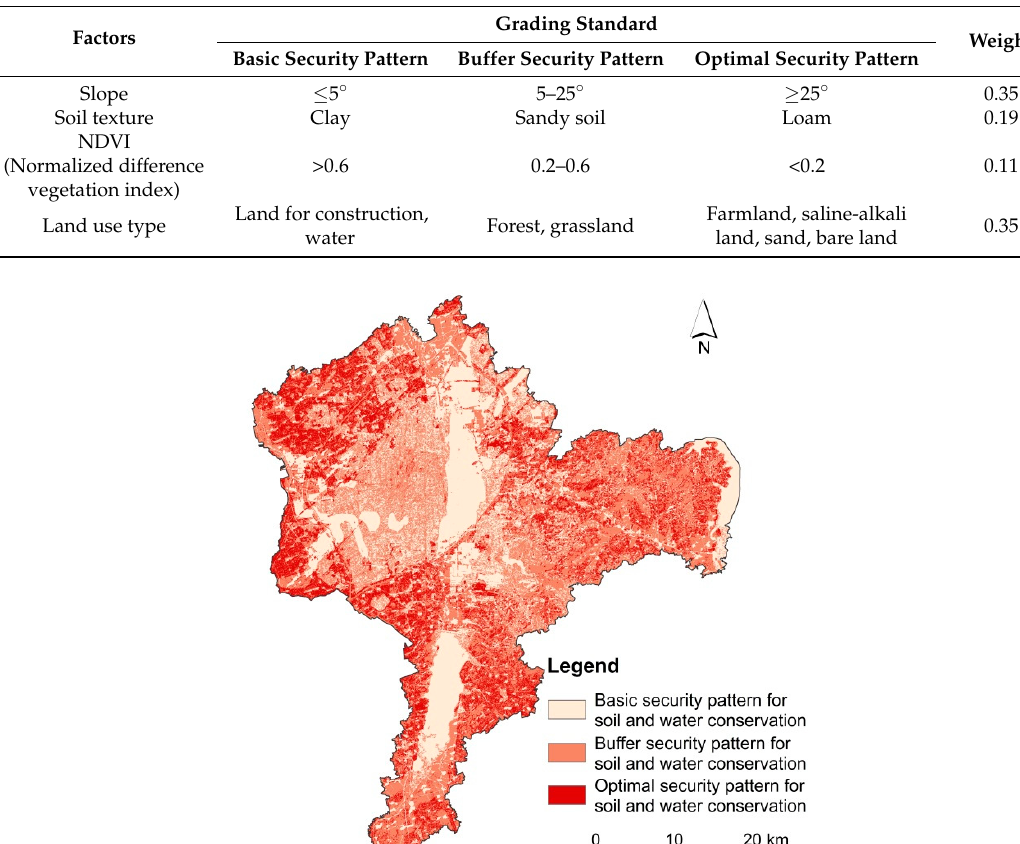
Table 2. Grading standard for soil and water conservation security pattern of basic, buffer and optimal levels.